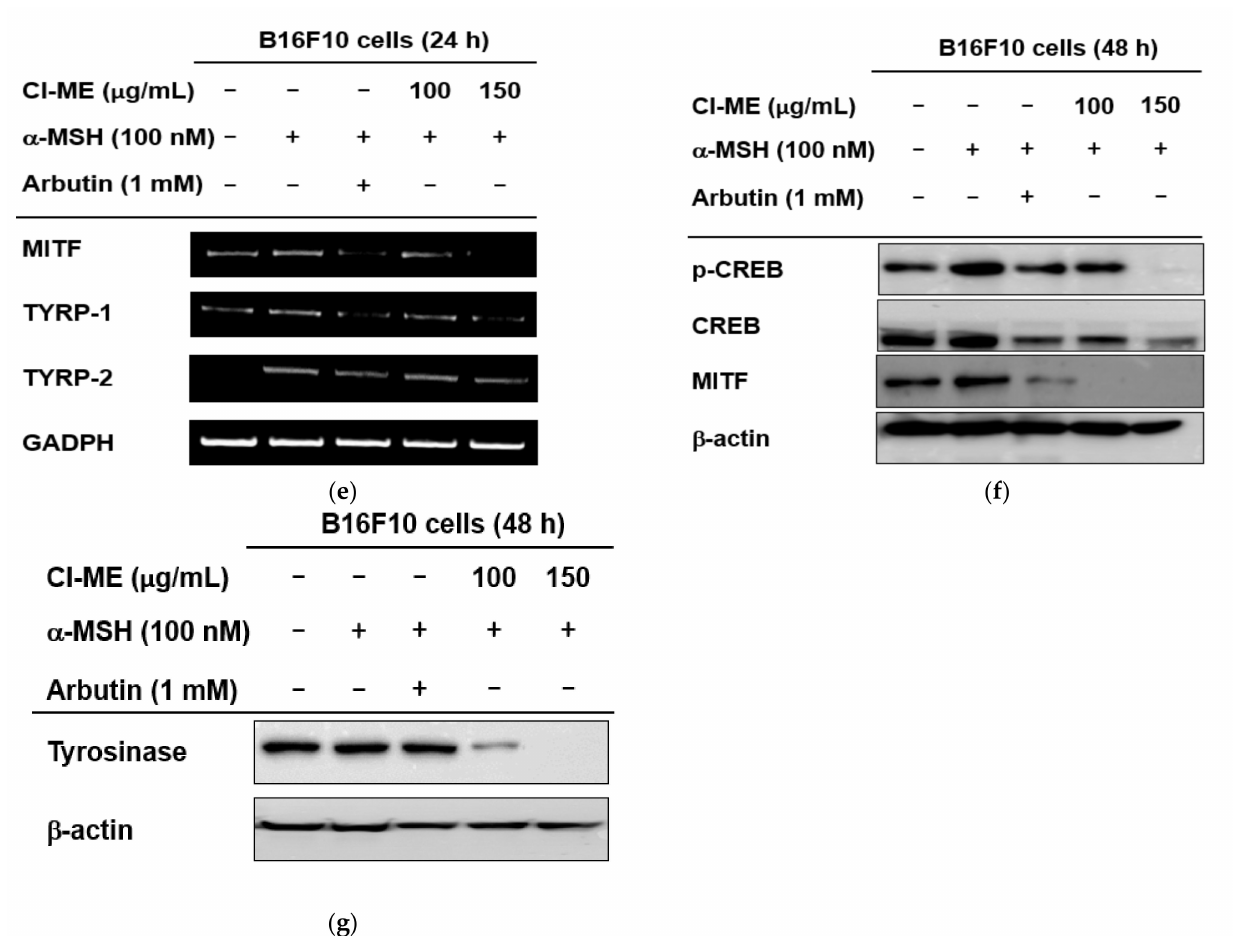
Figure 5. Antimelanogenic effect of Cl-ME in murine melanoma B16F10 cells. ( a ) Melanin secretion in B16F10 cells after 48 h of treatment with Cl-ME (0–150 µ g/mL); arbutin (1 mM) was used as the positive control. ( b ) Melanin content in B16F10 cells after 48 h of treatment with Cl-ME (0–150 µ g/mL) with arbutin (1 mM) as the positive control. ( c ) Tyrosinase activity assay of Cl-ME (0–200 µ g/mL) with kojic acid (300 µ M) as the positive control. ( d ) CREB-mediated luciferase activity in α -MSH- activated B16F10 cells after 48 h of treatment with Cl-ME (0–150 µ g/mL). ( e ) Expression of MITF, TRP-1, and TRP-2 proteins in α -MSH-activated B16F10 cells after a 48 h treatment with Cl-ME (0–150 µ g/mL). ( f ) Phosphorylated forms of CREB and total amounts of CREB and MITF in α